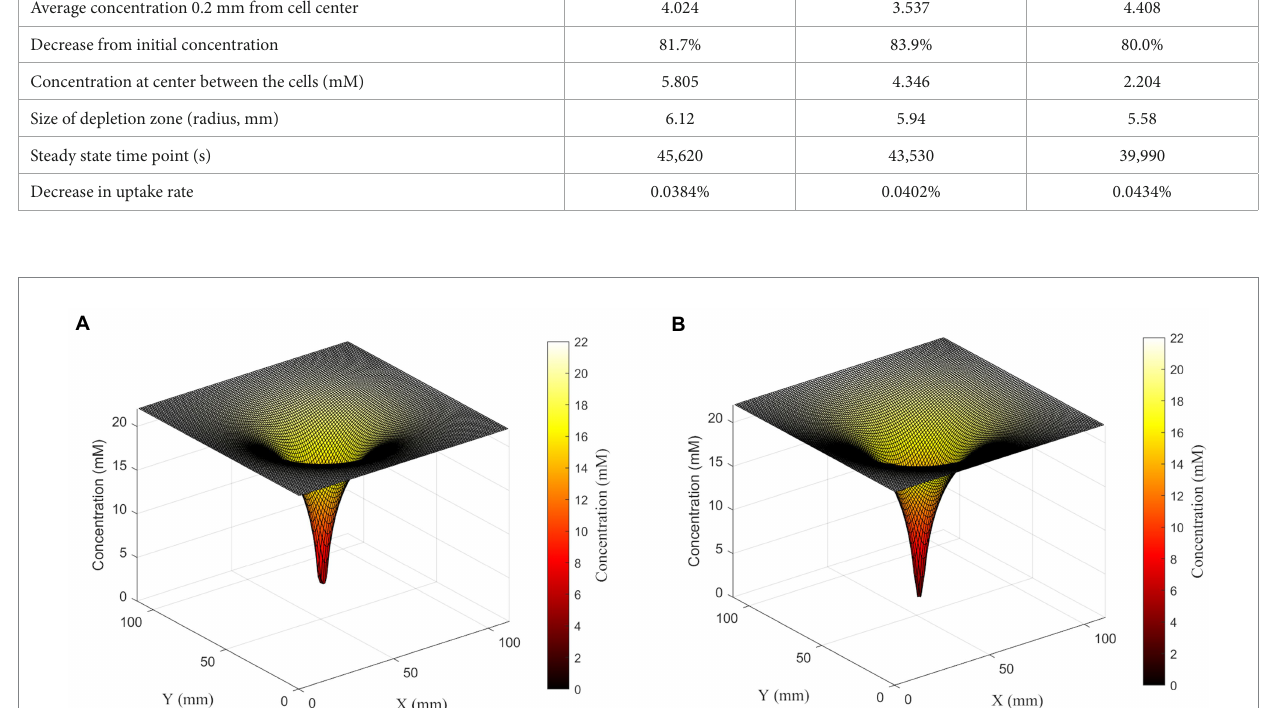
FIGURE 4 Surface plots showing glucose concentration field around a set of four cells in the linear configuration (left) or square configuration (right). Although cells are 360 μ m apart from each other, cells in both configurations form one deep concentration gradient. Glucose concentration is shown both on the z -axis and in the color gradient.